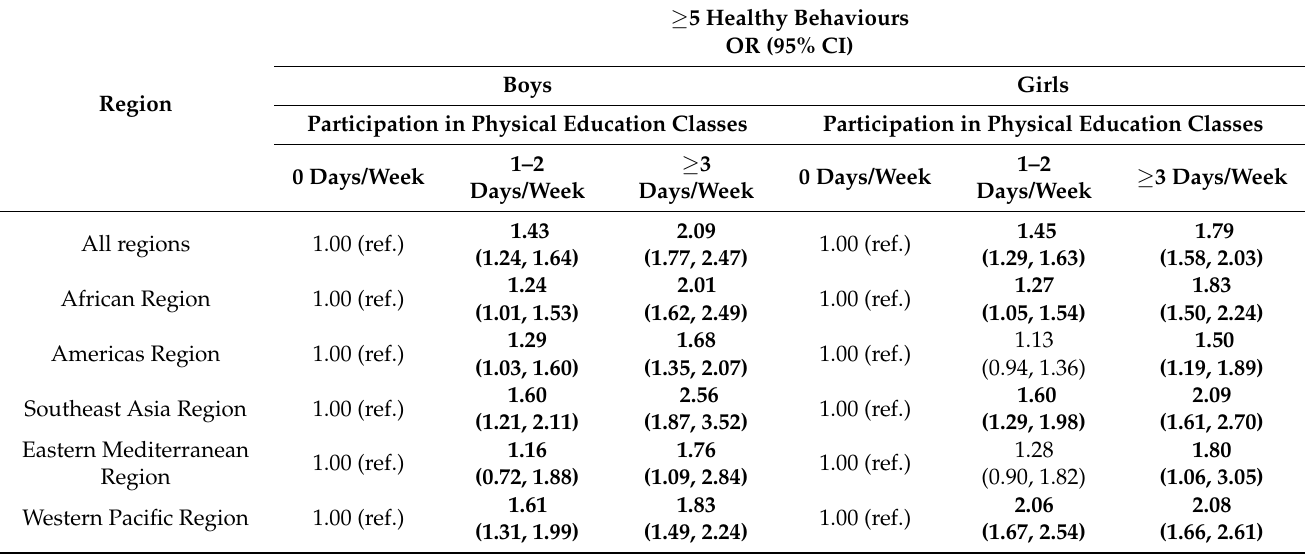
Table 4. Relationship between ≥ 5 healthy behaviours and participation in PE classes, stratified by